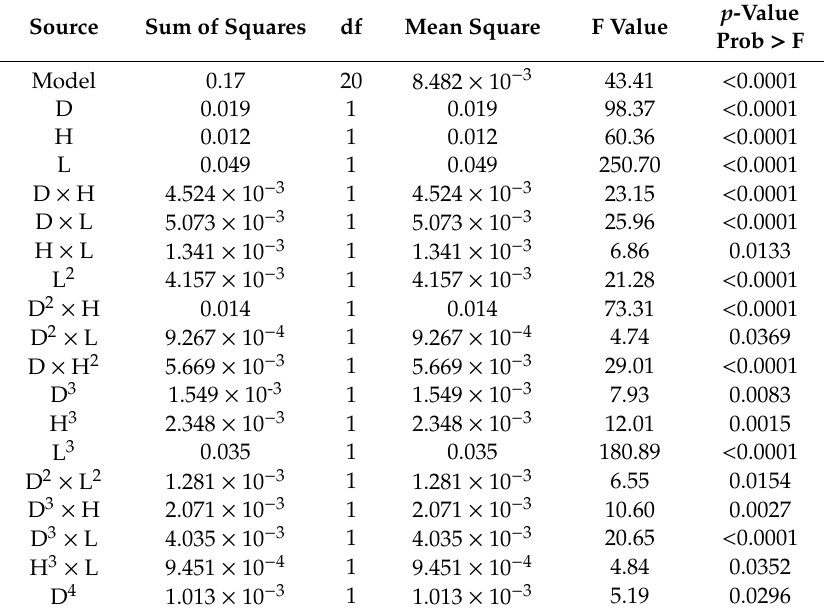
Table 4. Analysis of variance (ANOVA) for liquid maldistribution by quartic modeling.